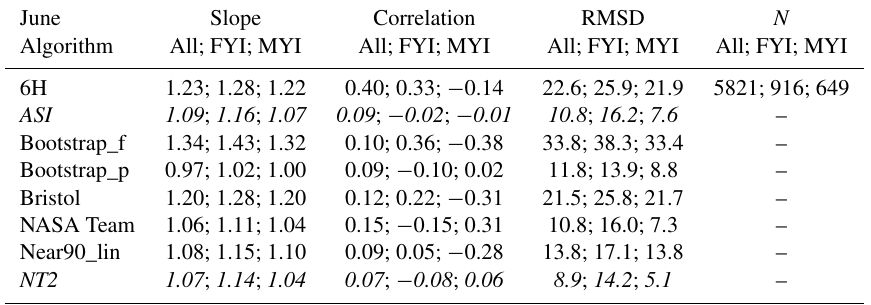
Table 8. Statistical parameters of the comparison AMSR-E sea-ice concentration vs. MODIS ice-surface fraction for MODIS sea-ice concen- tration > 90% (see Fig. 5) for June 2009. Each column gives the value for all grid cells with MODIS sea-ice concentration > 90%, and the respective multiyear (MYI) and first-year ice (FYI) grid cells. Values obtained for the ASI and NT2 algorithm are shown for completeness but are in italic font.